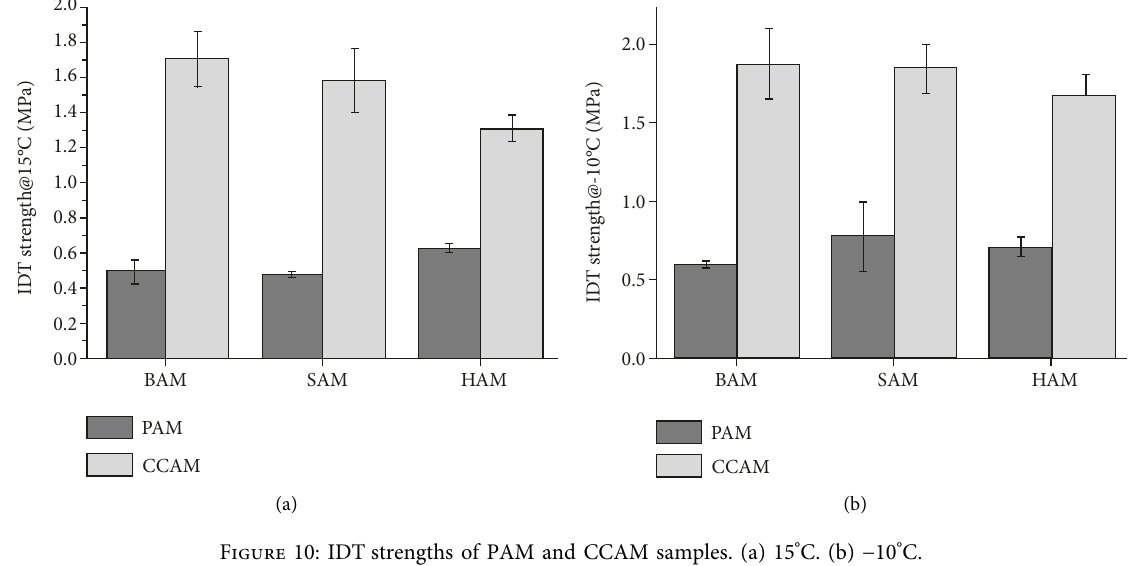
Figure 10: IDT strengths of PAM and CCAM samples. (a) 15 ° C. (b) − 10 ° C.